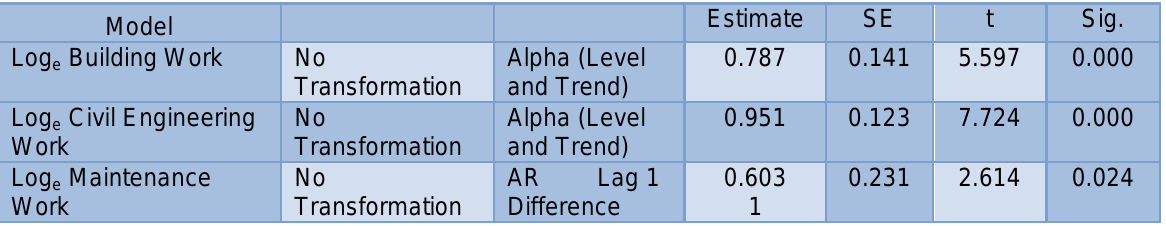
Table 1 Model Parameters for Forecasted Construction